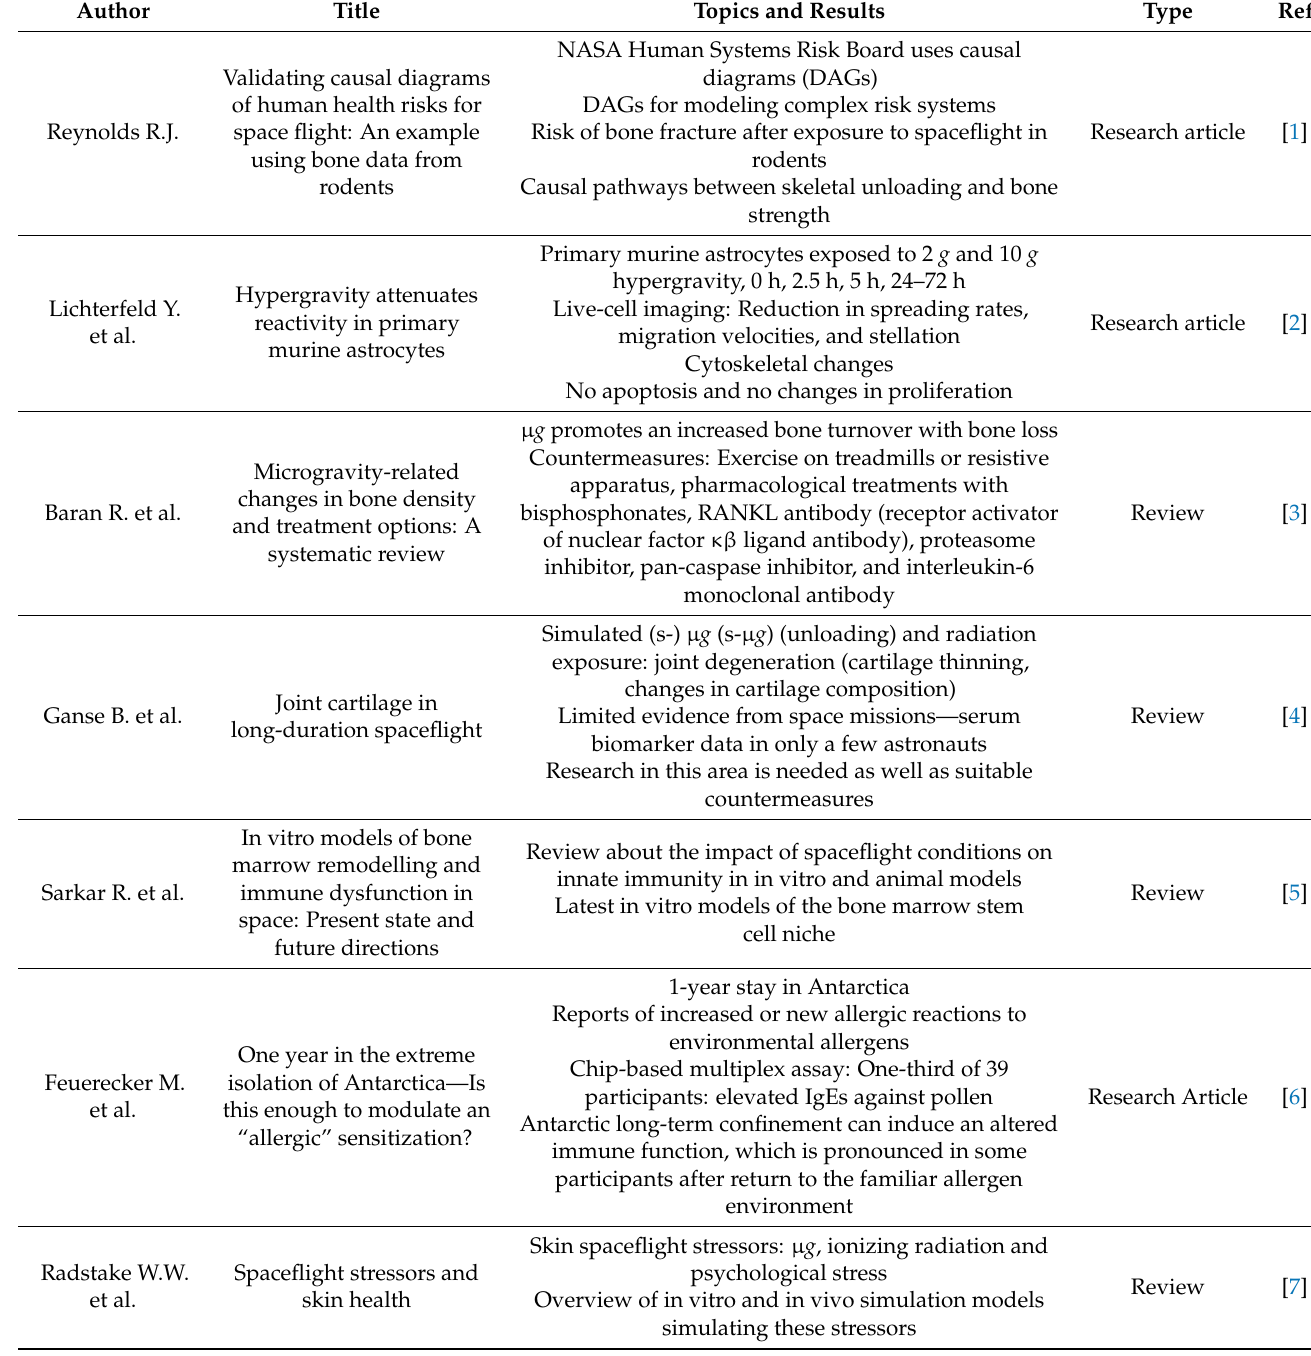
Table 1. Contributions to the Topic “Translation from Microgravity Research to Earth